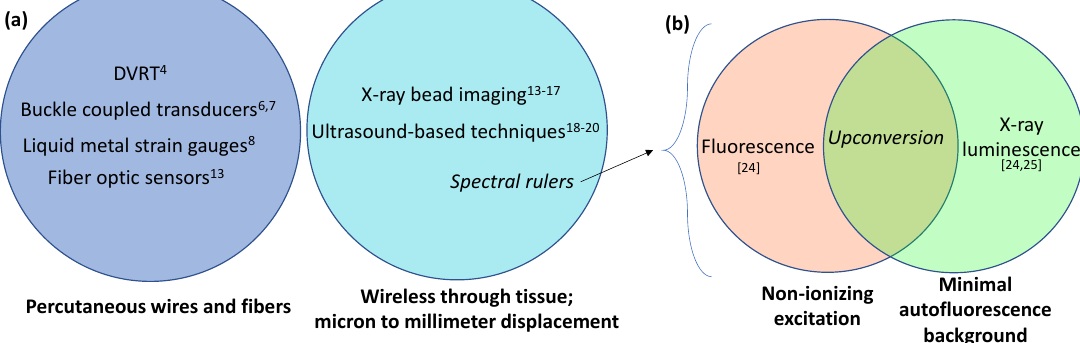
Figure 1. Venn diagram comparing several strain measurement techniques that could be applied to tendon strain measurement: ( a ) Wireless vs. percutaneous wires or fibers; ( b ) spectral rulers with three types of excitation/emission mecha- nisms.